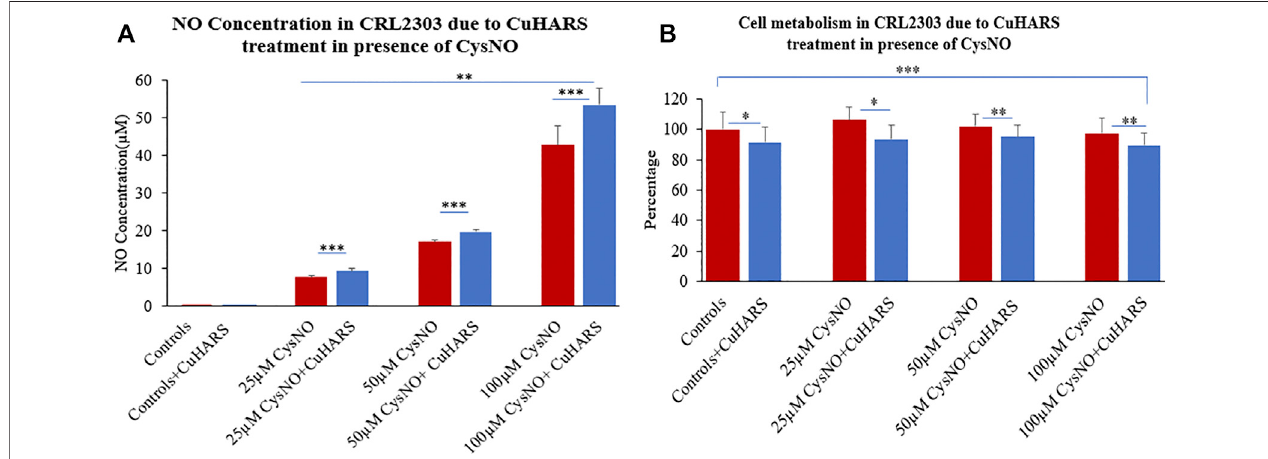
FIGURE 3 | CRL2303 glioma cell response to 20 μ g/ml CuHARS treatment in presence of three different concentrations (25, 50 and 100 µM) of CysNO, an NO precursor normally found in blood. (A) NO concentration in the cells due to the treatment showing signi fi cant increase in NO release from CRL2303 cells treated with CuHARS compared to cells treated with CysNO alone. (B) Cell metabolism due to the treatment showing inhibition of cell metabolism for CuHARS treated cells. Data representaverageofthreeexperiments( N (cid:2) 3)withtriplicatedwells( n (cid:2) 3).TheerrorbarsrepresentSEMvalues, “ *** ” represents p < 0.001, “ ** ” represents p < 0.01 and “ * ” represents p <